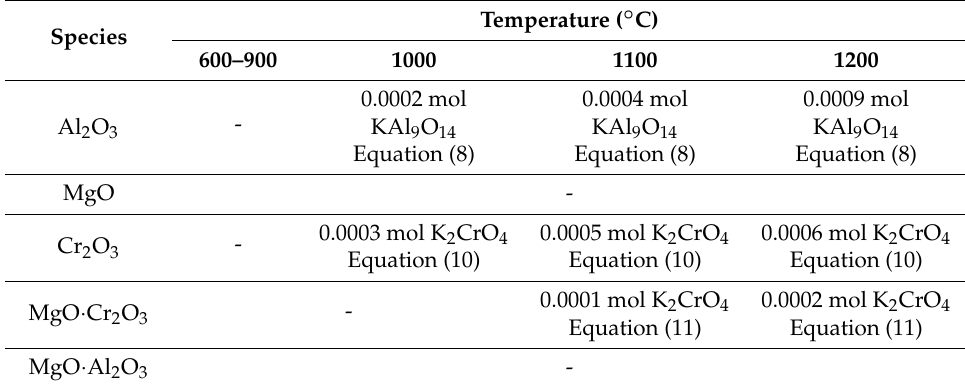
Table 3. Corrosion products and reaction equations of KCl reacting with the five components of refractory